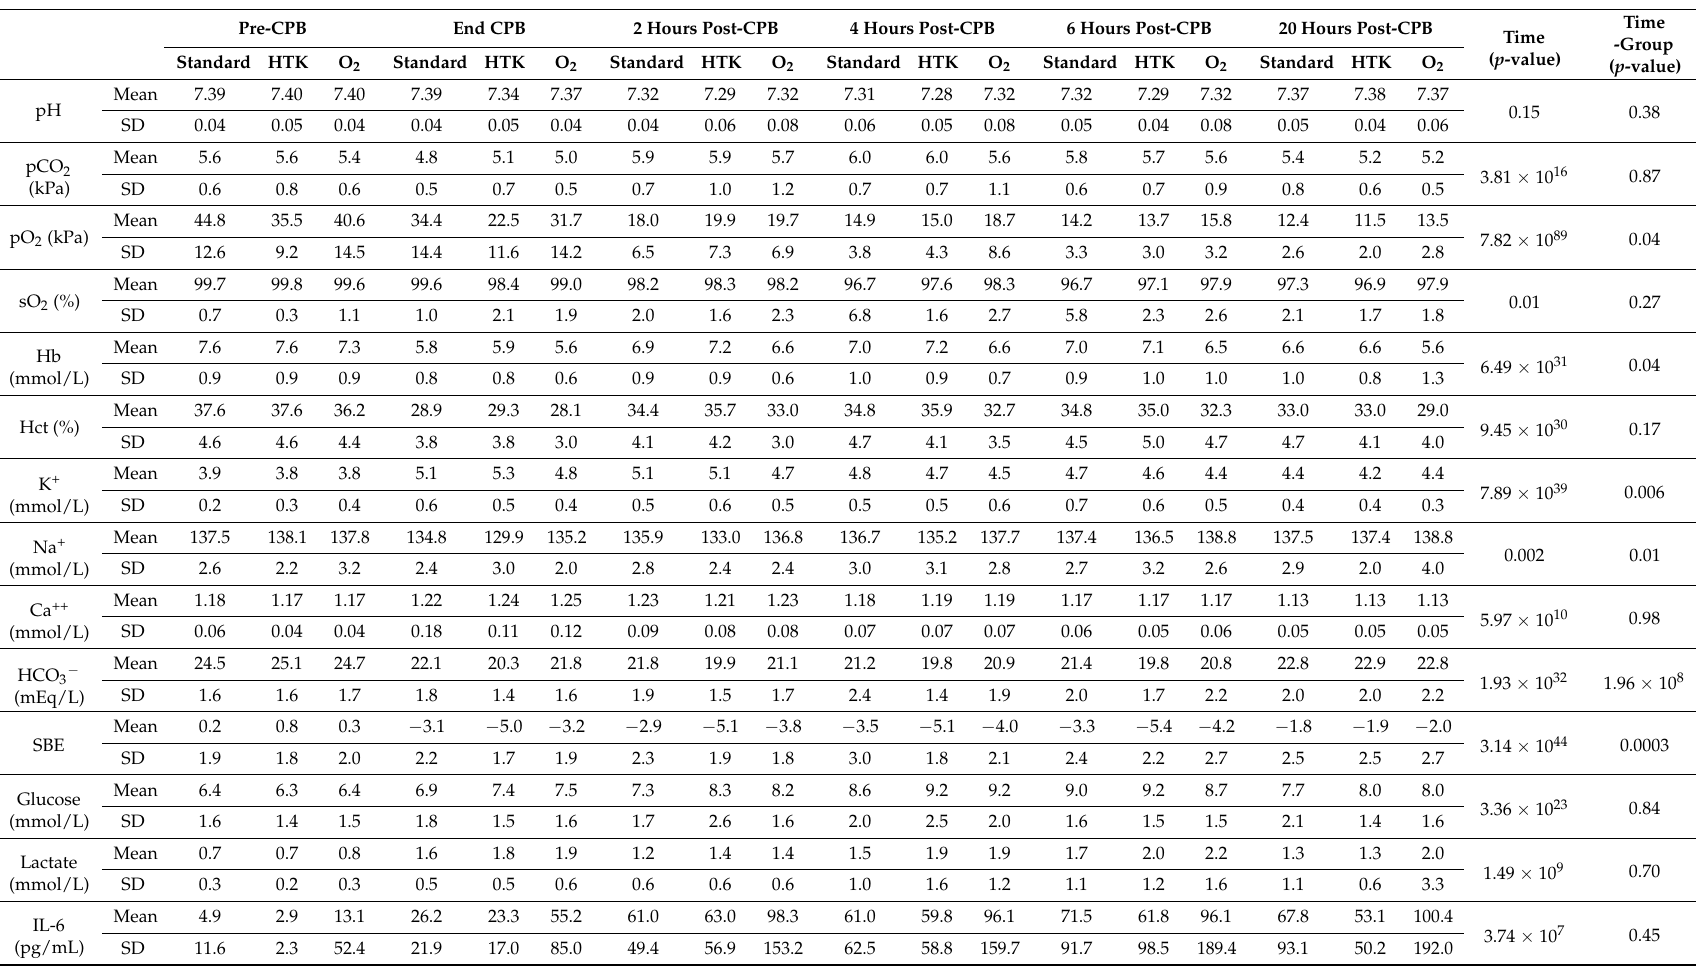
Table 2. Results of arterial blood gas analyses and interleukin-6 in samples collected before CPB, at the end of CPB, and 2, 4, 6, and 20 h